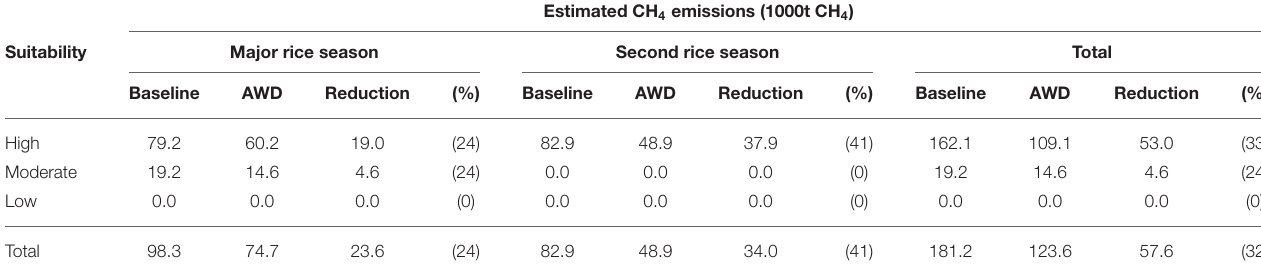
TABLE 7 | Estimated CH 4 emissions in the baseline and AWD adoption